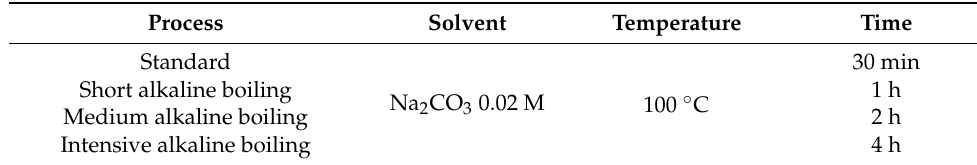
Table 1. Overview of the used degumming